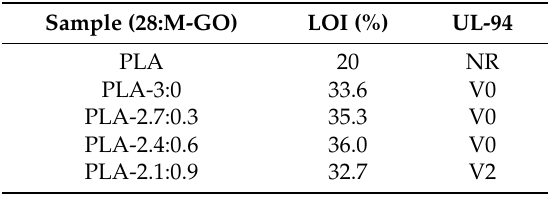
Table 9. Flammability of PLA composites of 28